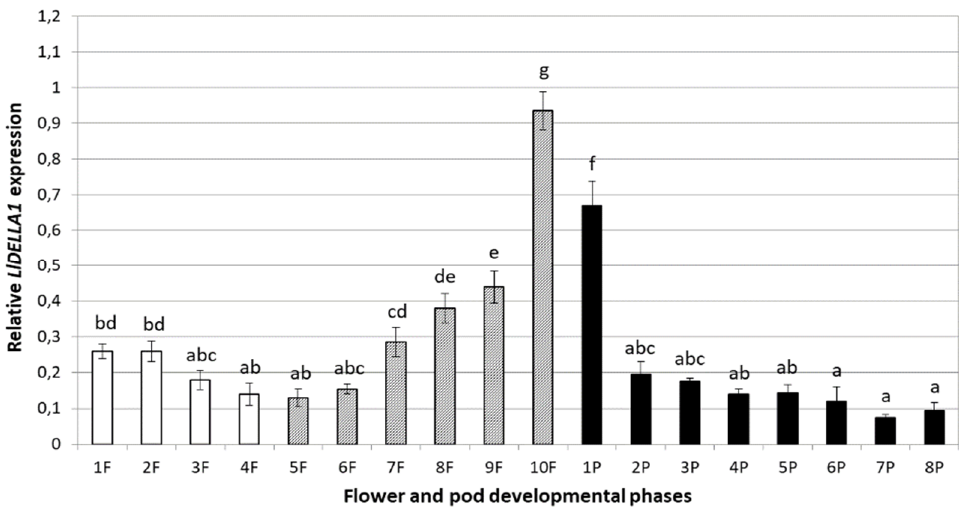
Figure 7. Expression profile of LlDELLA1 in di ff erent stages of generative organ development—flowers (1F–10F), early development of pods (5F–10F, marked in gray), and late development of pods (1P–8P, marked in black) in yellow lupine. The average value with ± SE of the three repetitions containing three replicates ( n = 9) was used to draw the figure. The letters represent statistically significant di ff erences at p < 0.05 (one-way ANOVA, followed by Tukey’s HSD test).